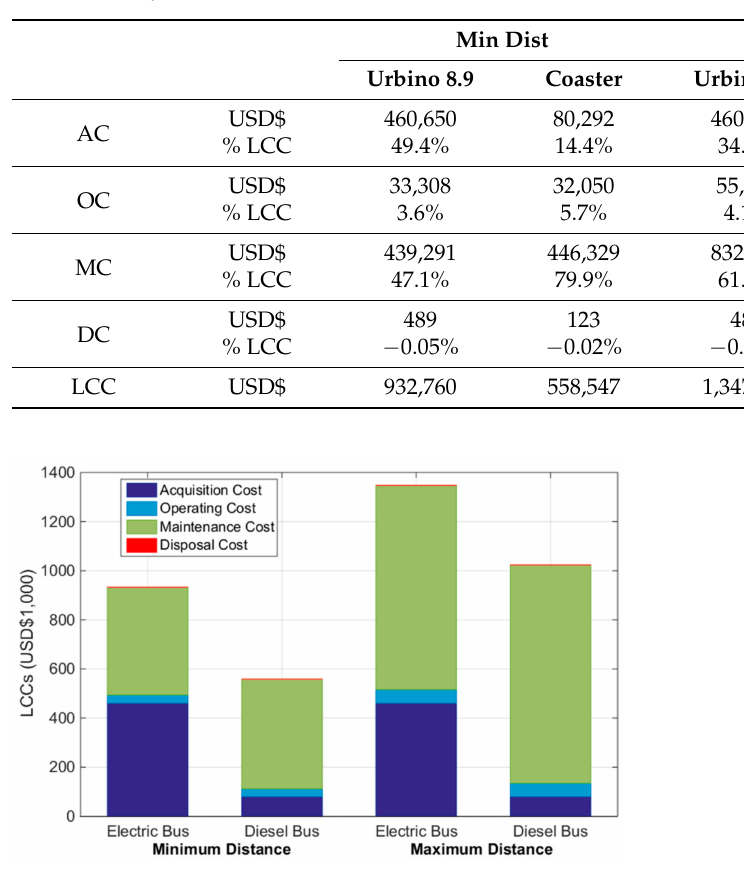
Table 4. Life cycle cost of electric and diesel buses, for the minimum and maximum routes.